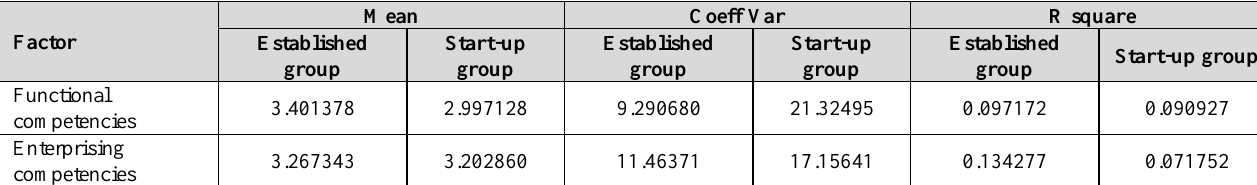
Table 5: ANOVA of the difference between the SMEs concerning importance